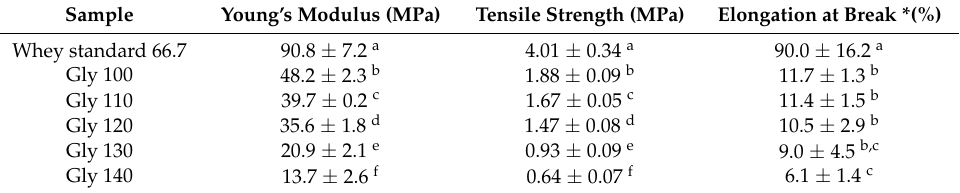
Table 3. Mechanical properties of WPI-based standard and PPI-based films as a function of glycerol concentration ( w / w protein). Significant differences between data sets are indicated by different superscript letters ( p <